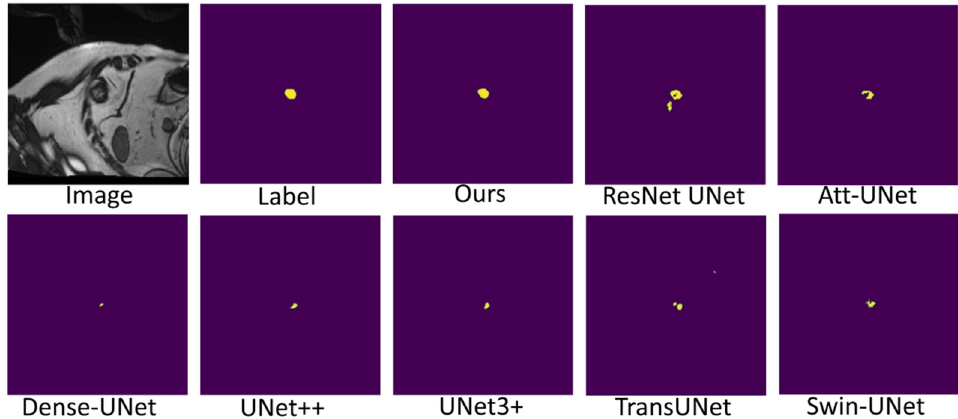
Figure 9. Comparison of left ventricle (LV) segmentation results.